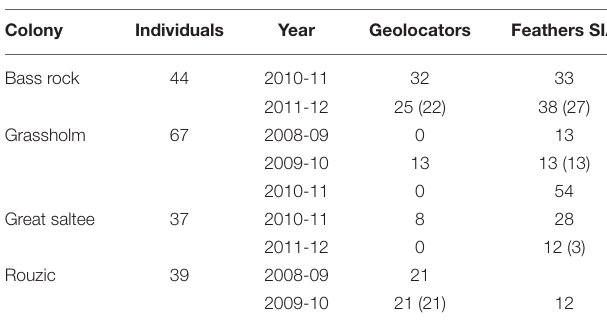
TABLE 1 | Summary of samples collected from 187 northern gannets across four breeding colonies between 2008 and 2012 including geolocation loggers and feather stable isotope analysis